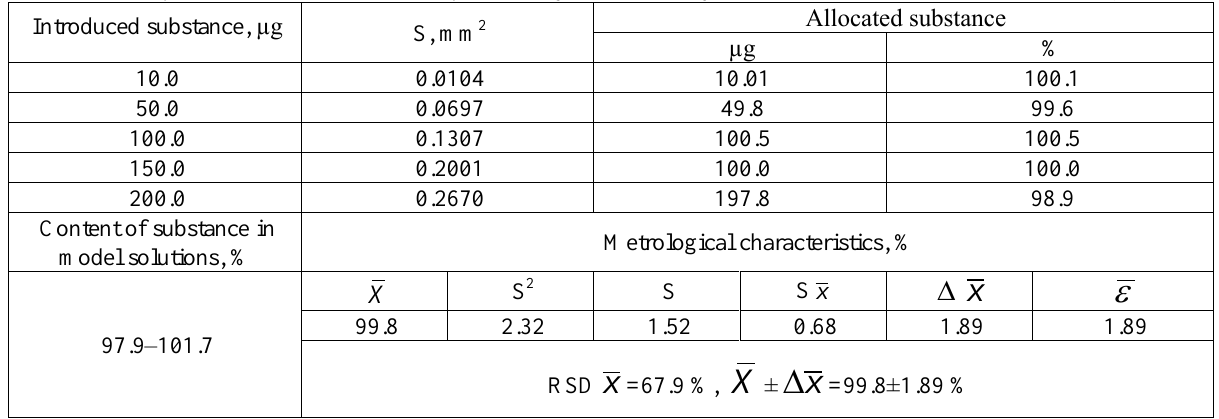
Results of the quantitative determination of prazosin hydrochloride by HPLC method in model solutions (n=5, P=95 %) Introduced substance,